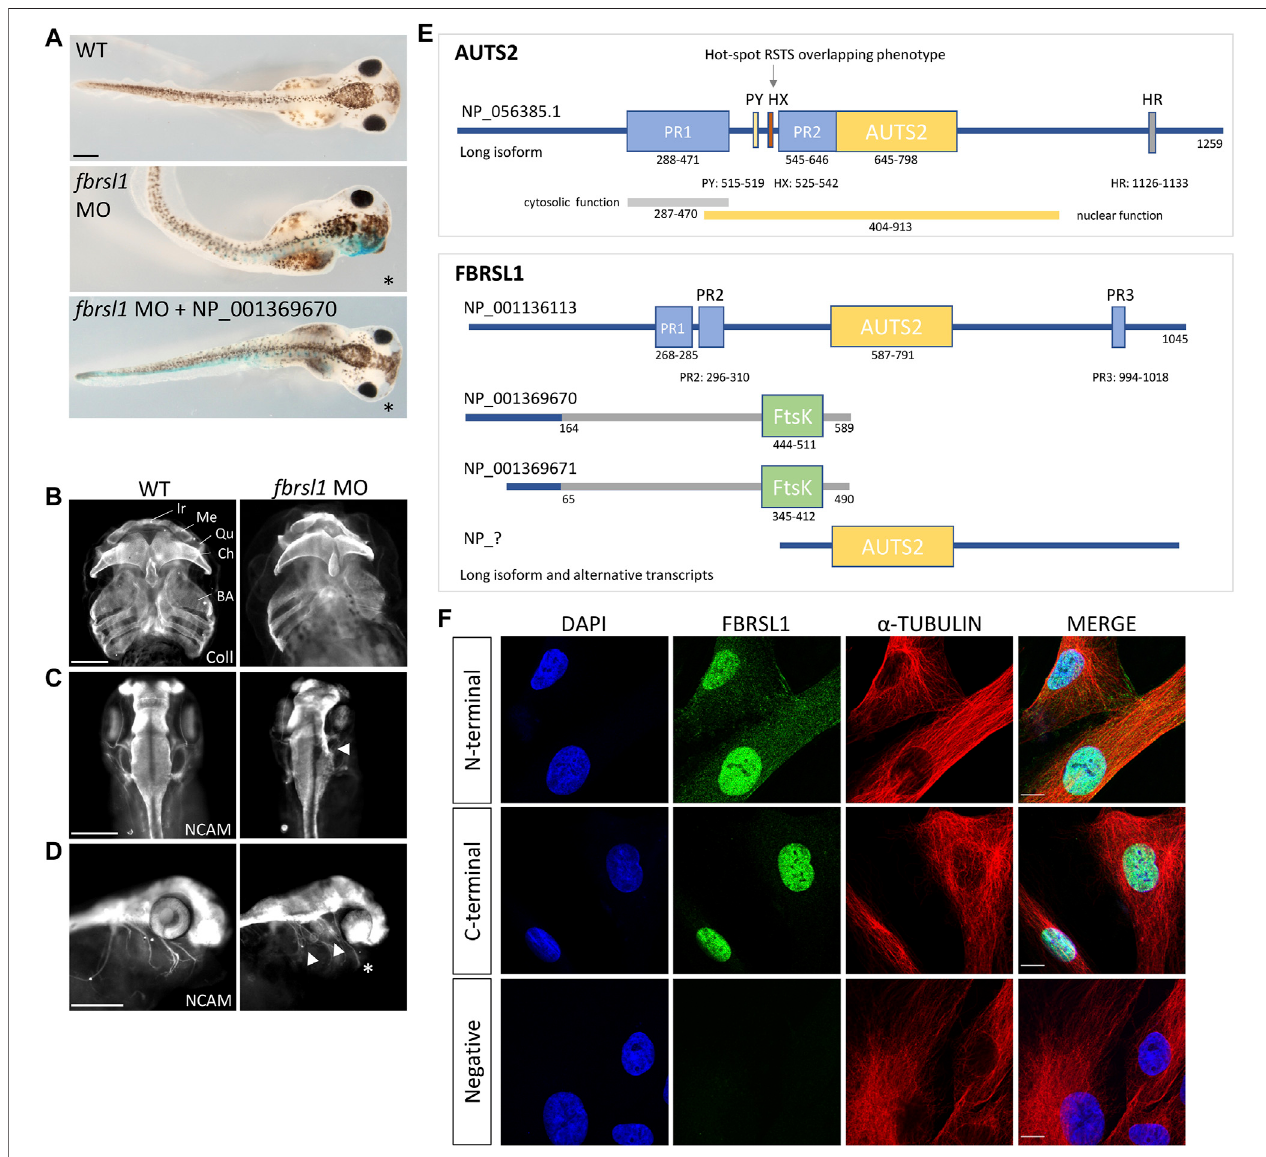
FIGURE 1 | Fbrsl1 knockdown phenotypes in Xenopus laevis and cellular localization of distinct human FBRSL1 transcripts. (A) Knockdown of Fbrsl1 by injection of a fbrsl1 Morpholino oligonucleotide (MO) leads to craniofacial defects that can be rescued by co-injection of RNA coding for the human short N-terminal FBRSL1 isoform NP_001369670 (Ufartes et al., 2020). LacZ RNA was co-injected as a lineage tracer, the injected side is marked by blue staining. (B) Anti-Collagen Type II immuno fl uorescence visualizes the cartilage and indicates cartilage hypoplasiaon the fbrsl1 MO-injected side. BA, branchial arches; Ch, ceratohyal; Ir, infrarostral; Me, Meckel ’ s cartilage; Qu, quadrate. (C) Neural cell adhesion molecule (NCAM) staining shows reduced brain size and (D) impaired outgrowth of cranial nerves on the fbrsl1 MO-injected side; * marks the injected side. Scale bar in A-D: 500 µm. (E) Human FBRSL1 transcripts/isoforms compared to the human AUTS2 long isoform as previously published (Sultana et al., 2002; Oksenberg and Ahituv, 2013; Sellers et al., 2020). Like its AUTS2 ohnolog, the long isoform has a AUTS2 domain and proline rich (PR) regions (predicted with MobiDB (Piovesan et al., 2020)). Both short N-terminal isoforms differ in their C-terminal sequence from the long isoform (presented in grey) due to an alternative exon 3, which contains an Ftsk-domain. In addition, a predicted C-terminal isoform (marked with “ ? “ ) including the AUTS2 domain is shown as this isoform was validated for mouse Fbrsl1. PR, proline-rich domain; PY, PPPY motif; HX, hexanucleotide repeat; HR, trinucleotide (H) repeat; AUTS2, AUTS2/FBRSL1/FBRSL homology region. (F) Immuno fl uorescence analysis performed on human fi broblasts. Antibodies directed against the N-terminal as well as the C-terminal part of FBRSL1 detected FBRSL1 isoforms (green) in the nucleus. However, only the N-terminal FBRSL1 antibody also detected FBRSL1 in the cytoplasm, suggesting that the short N-terminal FBRSL1 isoforms show cytoplasmic and nuclear localization. The negative control showed no signal. Cytoskeletal stainingwasdetectedusing an α -Tubulinantibody and nuclei werestained using DAPI.Images wereobtained using aconfocal lasermicroscope with × 600 magni fi cation. Scale Bar: 10 µm. All experimental data have been previously published (Ufartes et al., 2020).